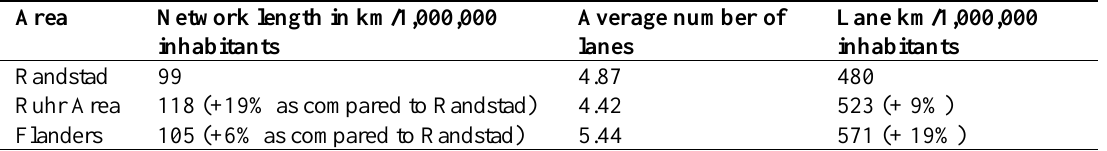
Table 8. Size of road networks in three regions Area Network length in km/1,000,000 Average number of Lane km/1,000,000 inhabitants lanes inhabitants Randstad 99 4.87 480 Ruhr Area 118 (+19% as compared to Randstad) 4.42 523 (+ 9%) Flanders 105 (+6% as compared to Randstad) 5.44 571 (+ 19%)